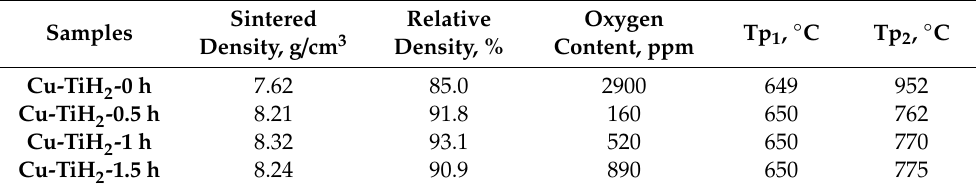
Table 2. A summary of densities, oxygen contents and expansion peak temperatures of the sintered samples of Cu-0.5 wt. %TiH 2 hold at 650 °C for different time.